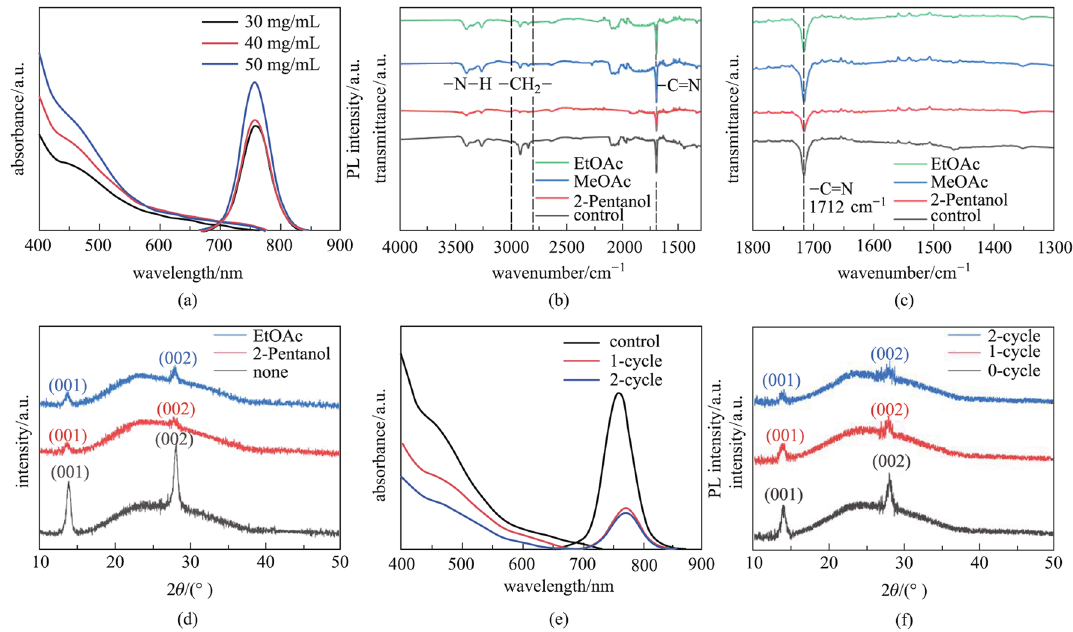
Fig. 2 Surface ligand management for FAPbI 3 PQDs. a UV–visible absorption and PL spectra of the FAPbI 3 PQD solid film prepared with dif- ferent concentrations of PQD solution. b FTIR spectra, c expanded view of FTIR spectra in the range of 1300 to 1800 cm −1 and d XRD pattern of the FAPbI 3 PQD solid film treated with different anti-solvents. e UV–visible absorption and PL spectra, f XRD pattern of the FAPbI 3 PQD solid film with increasing numbers of post-treatment